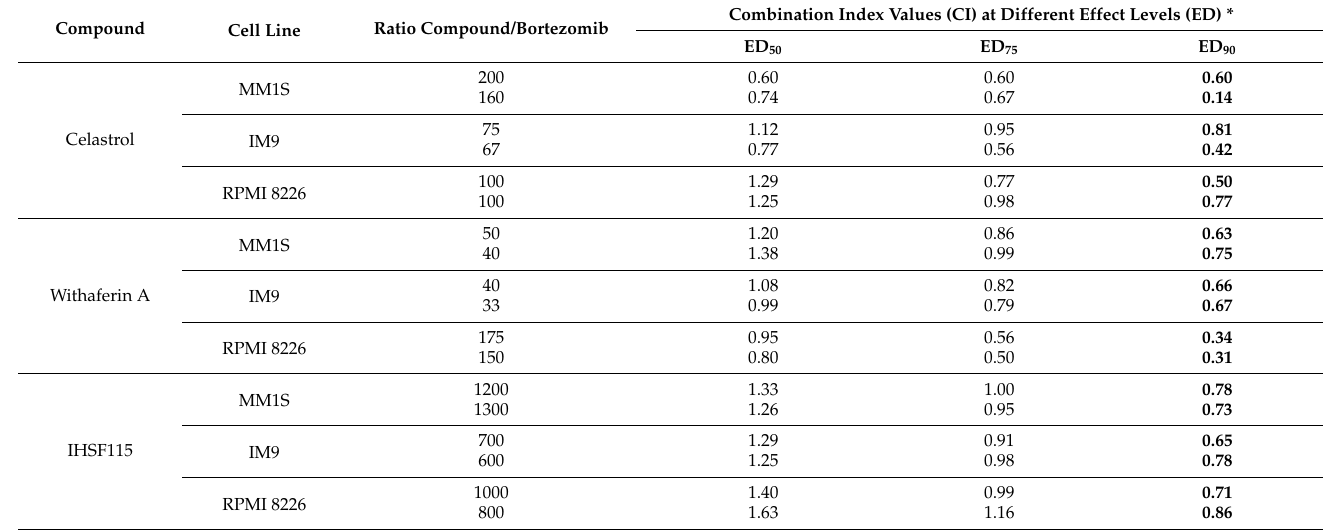
Table 1. Interactions of CEL, WA and IHSF115 with bortezomib in MM